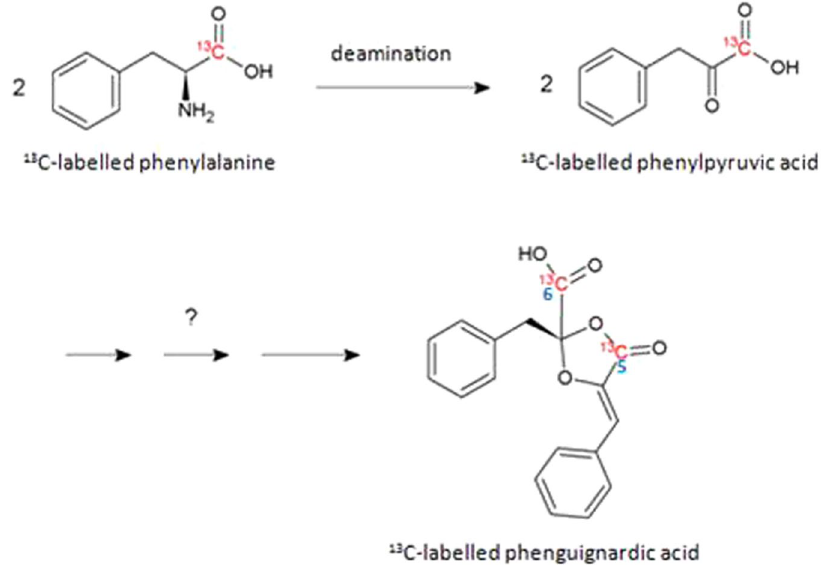
Figure 2. Hypothetical model of the biosynthesis of phenguignardic acid. Starting from two molecules of 1- 13 C-labelled phenylalanine, the amino group could be transferred and two molecules of phenylpyruvic acid could be generated. These molecules could fuse and form a dioxolanone moiety, whereby phenguignardic acid is